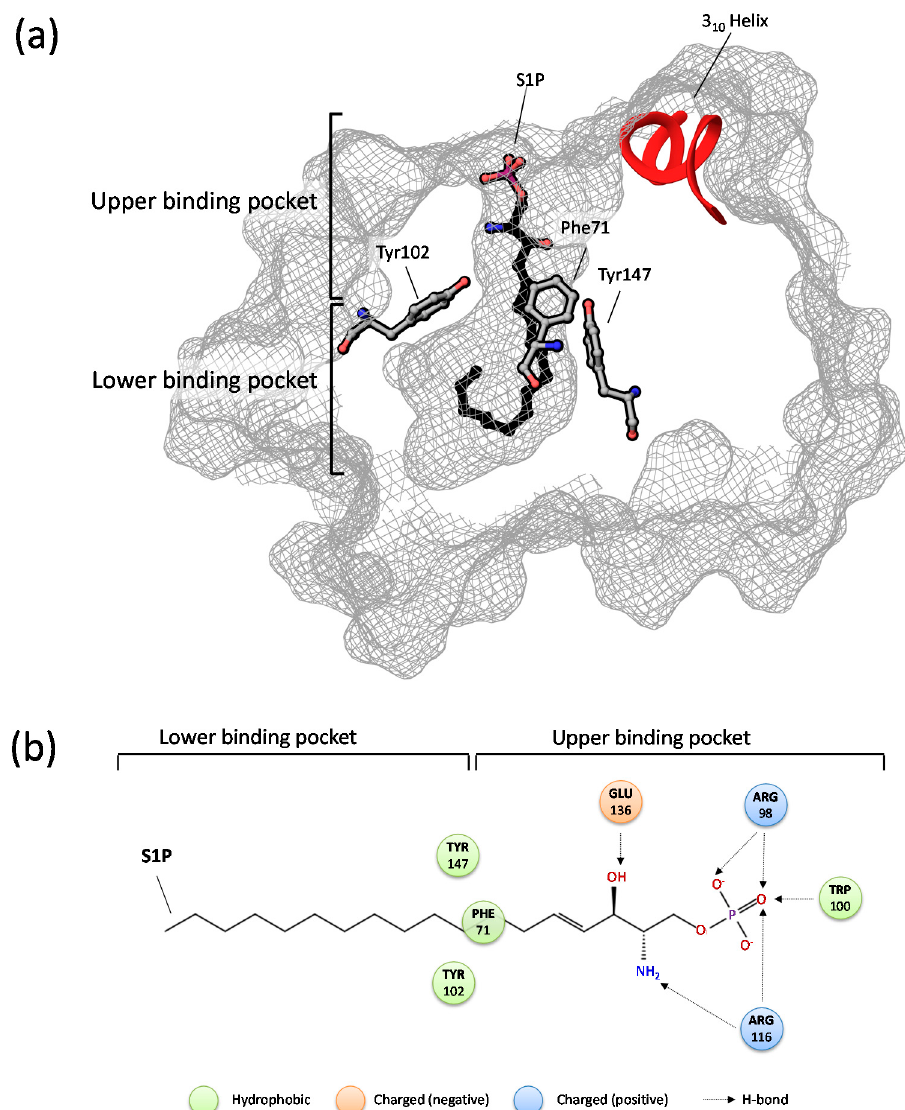
Figure 2. ( a ) Schematic representation of human apoM in complex with S1P. The amino acid residues Phe71, Tyr 102 as well as 147 play a leading role in separating the hydrophobic binding pocket into a lower and upper section. The 3 10 helix may furthermore play a significant role in recognition and binding of small molecules. ( b ) The upper part of the binding pocket exerts a critical role in fixating the S1P phosphate head in apoM via Arg98, Trp100, Arg116 and Glu136 interaction.